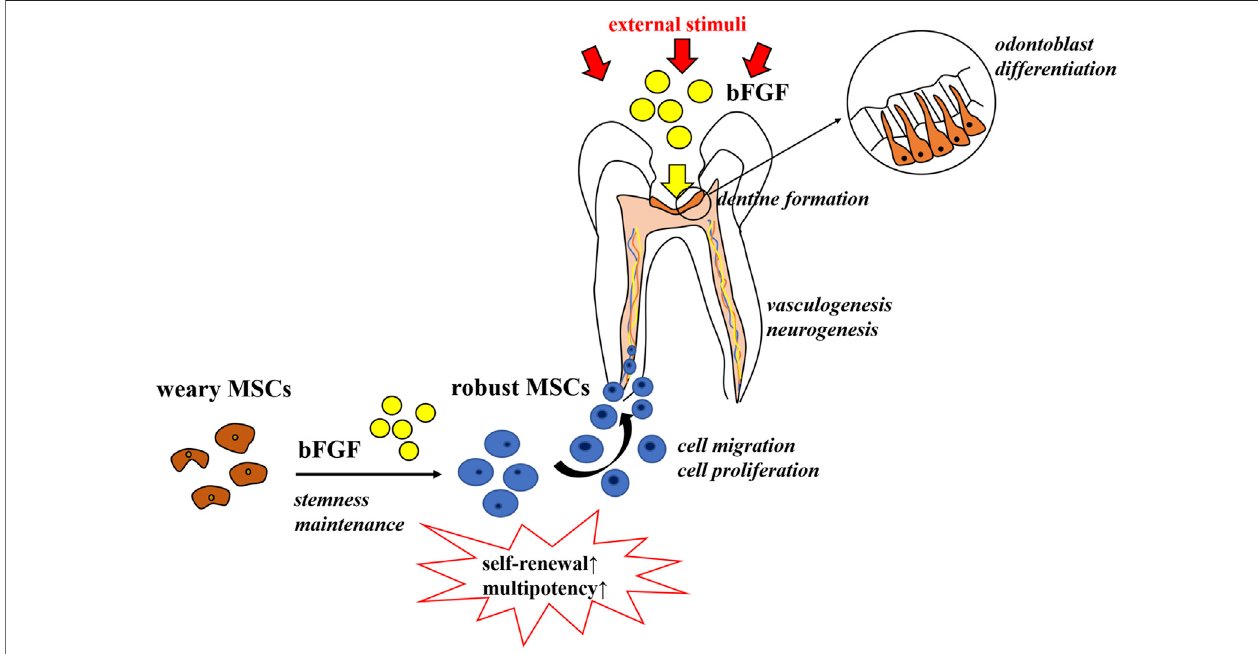
FIGURE 1 | Role of the bFGF in pulp repair and regeneration. The bFGF contributes to the regulation of virtually all aspects of tooth development, repair, and regeneration, including mesenchymal stem cells ’ stemness maintenance, migration, and proliferation, as well as dentine formation, vasculogenesis, and neurogenesis.